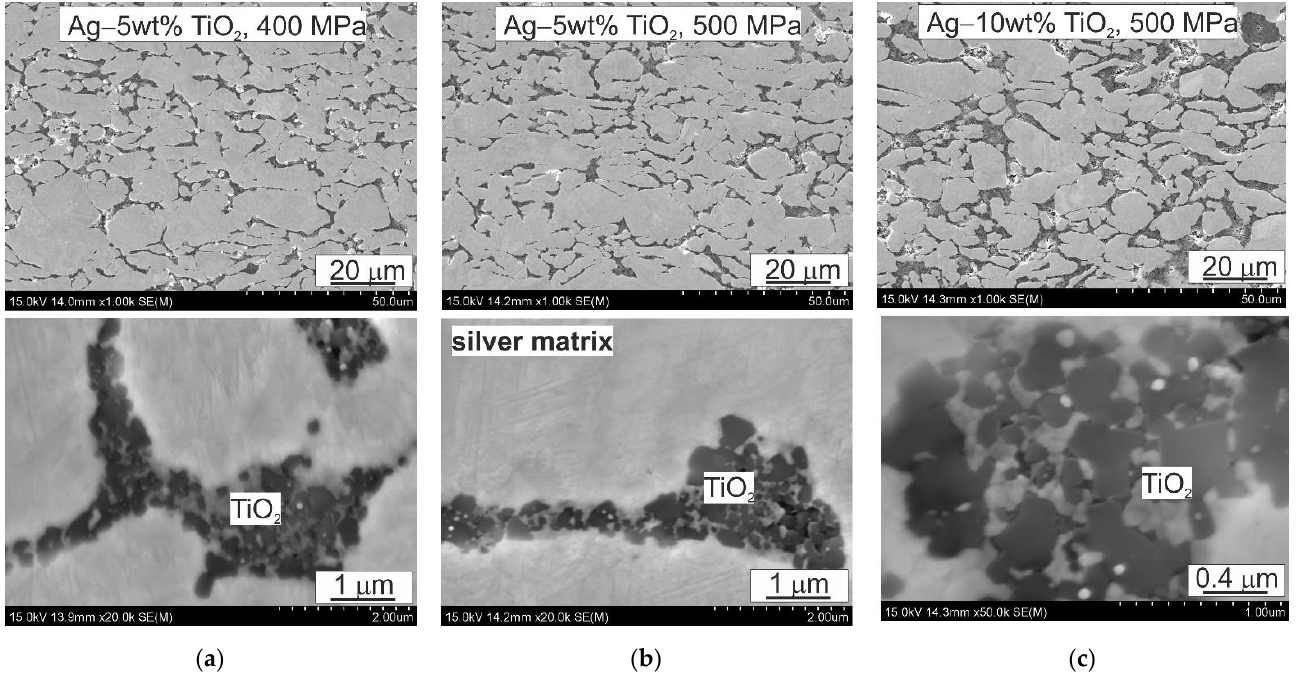
Figure 5. Composite microstructures: ( a ) Ag–5wt% TiO 2 , p = 400 MPa; ( b ) Ag–5wt% TiO 2 , p = 500 MPa; ( c ) Ag–10wt% TiO 2 , p = 500 MPa; SEM.